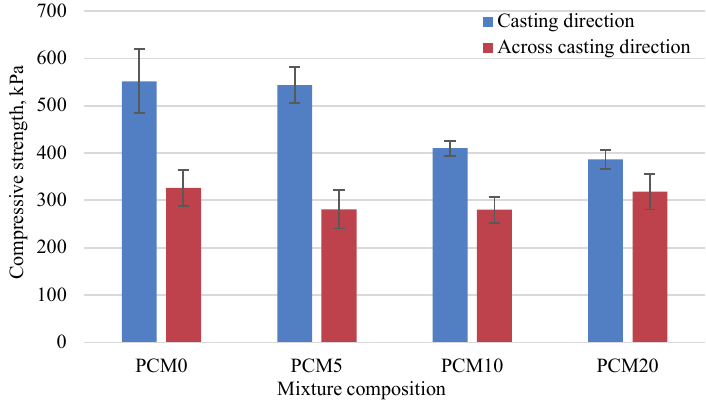
Fig. 6. Compressive strength of gypsum hempcrete with PCM at 10% deformation and depending on casting